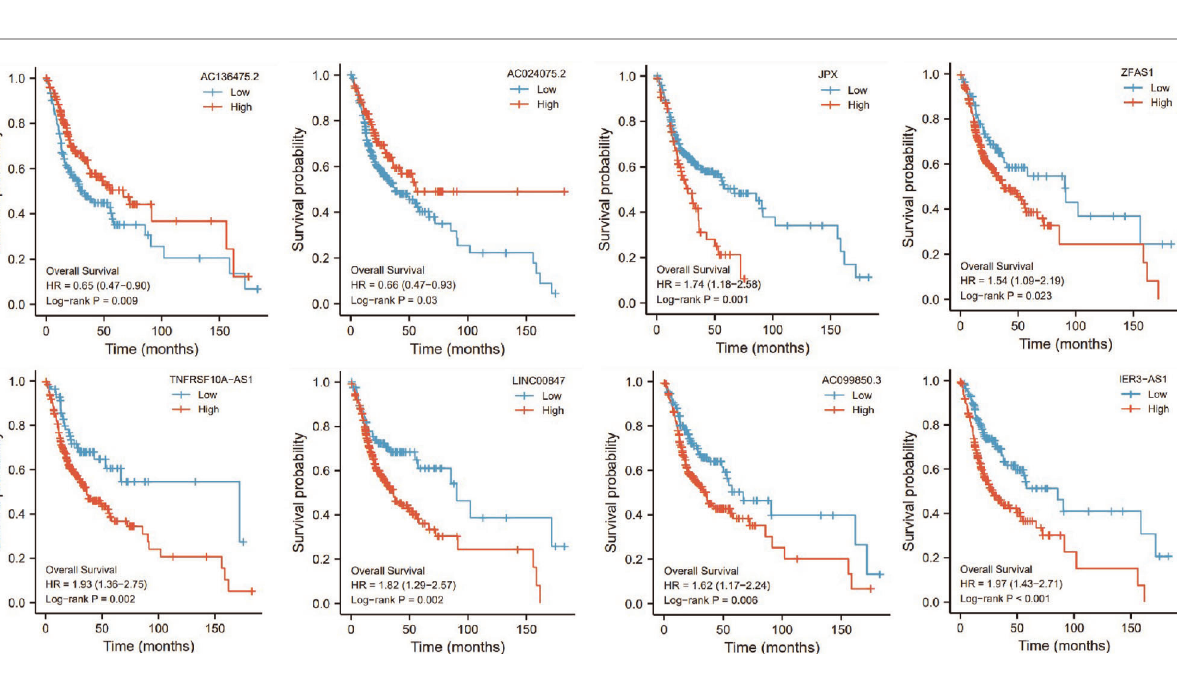
FIGURE 6 Independent testing of the association between the eight pyroptosis-related lncRNAs signature and prognosis of patients. ( A ) Univariate Cox regression analysis showed that the signature based on risk score ( P <0.001), T stage ( P =0.013), N stage ( P <0.001) and TNM comprehensive stage ( P =0.010) were signi fi cantly associated with patient survival. ( B ) Multivariate Cox regression analysis demonstrated that the signature based on risk score ( P =0.003) and N stage ( P =0.015) were independent factors associated with patient survival.